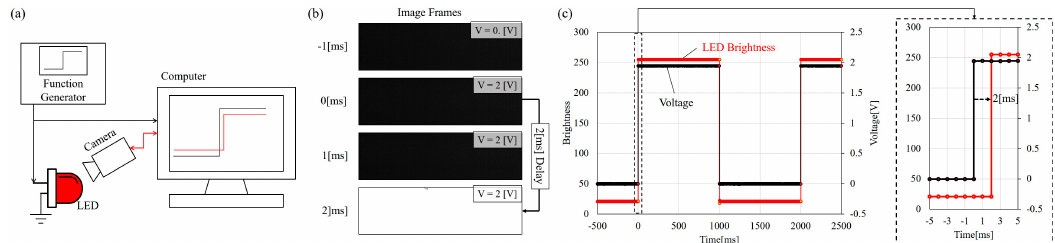
Figure 6. The measurement of time delay on the computer. ( a ) The diagram of the setting; ( b ) the signal sent to the light-emitting diode (LED) at 0 ms while the high-speed camera captured the LED response at 2 ms; and ( c ) the plot of the input and output in time delay test. The delay is 2 ms.